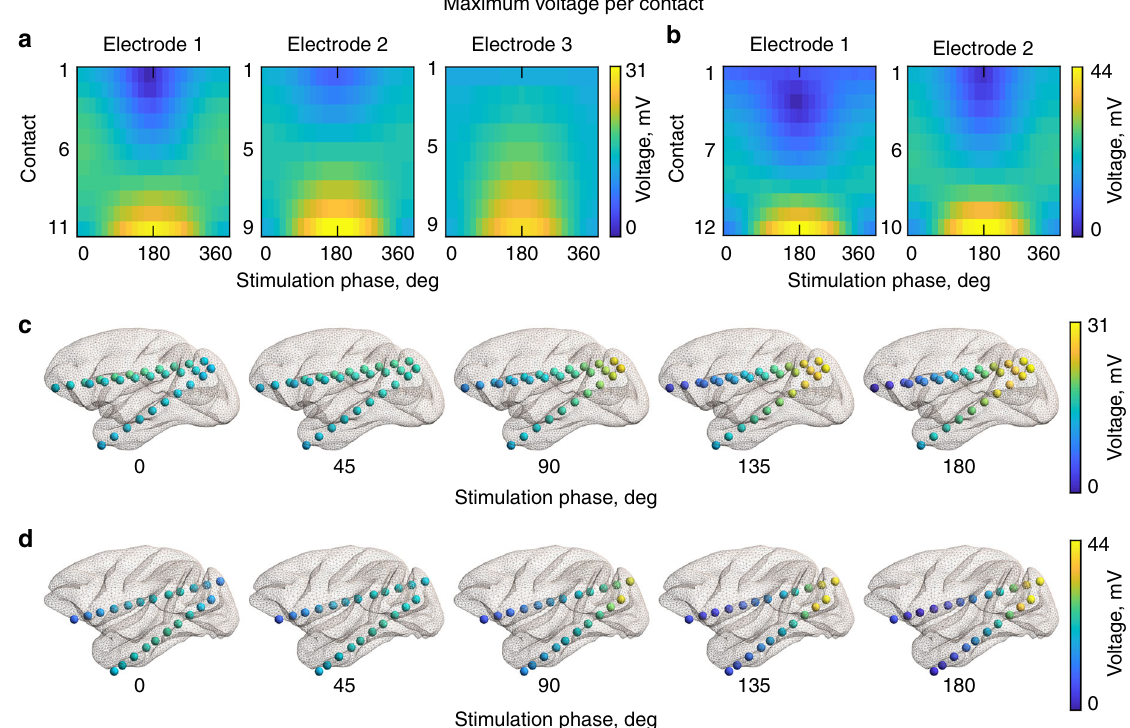
Fig. 2 Voltage distribution during TES for different stimulation conditions. a Heatmaps of the maximum voltage for each recording electrode for subject 1 (left) and subject 2 (right, b ). The x -axis indicates the applied phase difference between the anterior and posterior stimulation electrodes from 0° to 360° in 15° steps, and the y -axis corresponds to the recording contacts (from the fi rst — most anterior contact, to the last — most posterior contact). c Voltage gradients for select stimulation conditions for subject 1 and subject 2 ( d ) visualized at their recorded anatomical